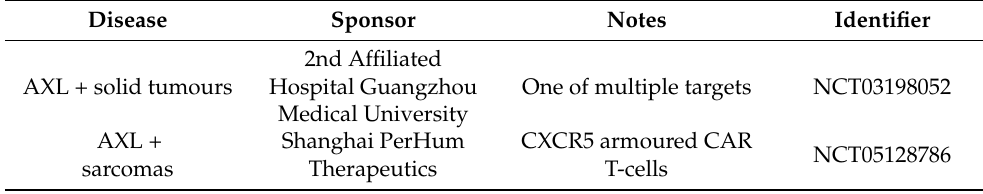
Table 3. Ongoing CAR T-cell clinical trials directed against AXL (accessed on 3 January